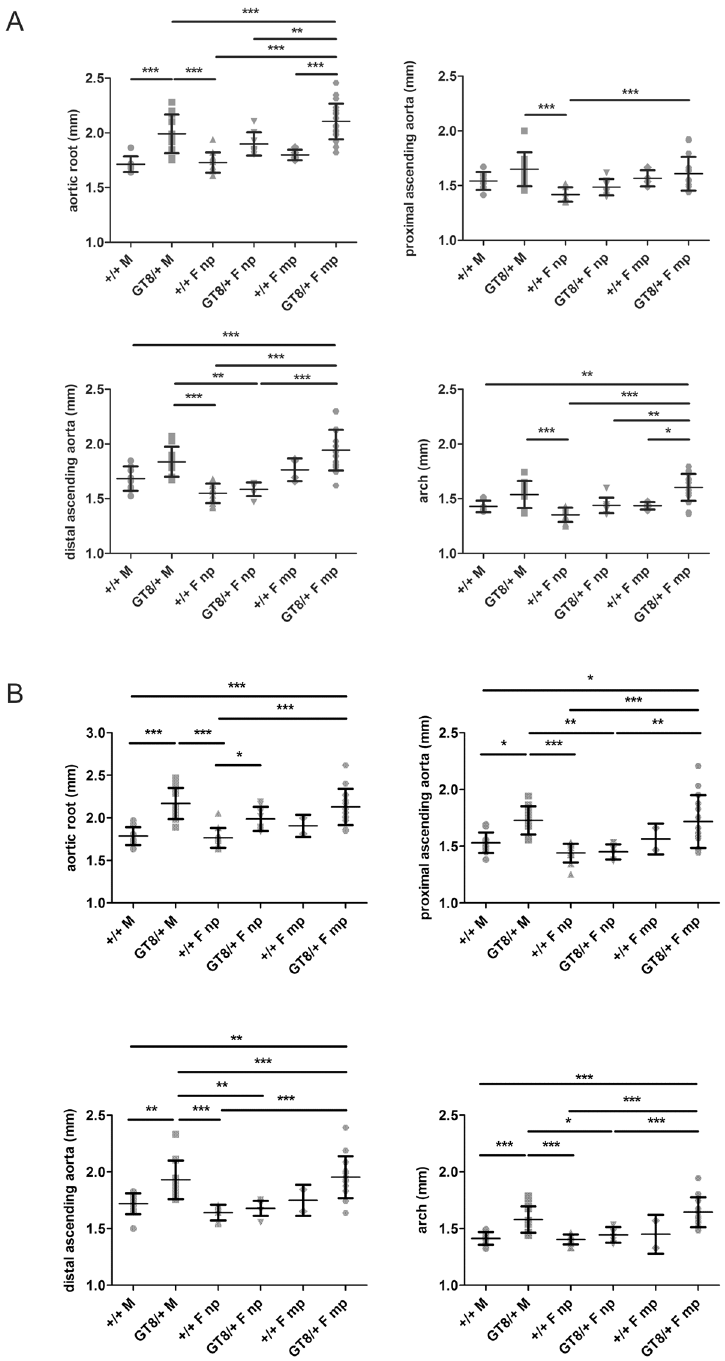
Fig 2. Aortic dimensions of wild-type (+/+) and heterozygous GT-8/+ males (M) and nulliparous (np) and multiparous (mp) females (F) at age 8 (panel A) and 12 months (panel B). Male and multiparous female GT-8/+ mice show more severe aortic diseasethan wild-typemice and nulliparousGT-8/+ females at both time points. NulliparousGT-8/+ females differed only significantly from the nulliparous wild-typefemales at the level of the aortic root at 12 months. In addition,nulliparous females have smaller aortic diameters than the GT-8/+ males. Black lines represent the mean ± standard deviation. Non-significant differences are not indicatedin the figure. p-values: * < 0.05, ** < 0.005, *** < 0.001, **** < 0.0001.